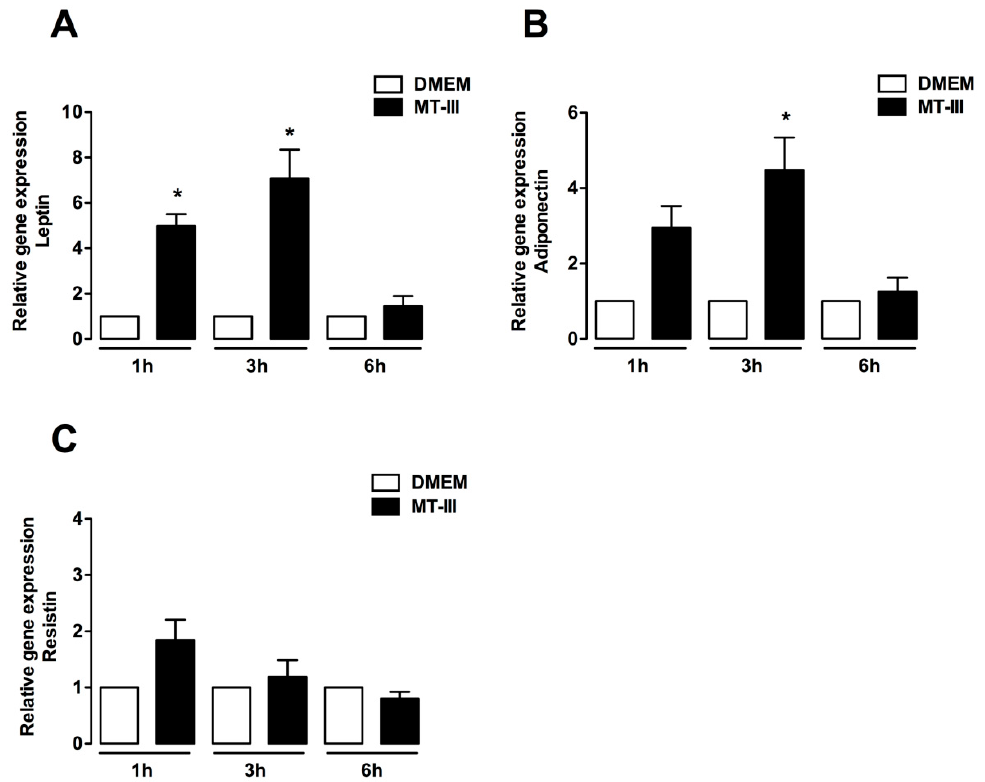
Figure 8. MT-III upregulates gene expression of leptin and adiponectin by 3T3-L1 preadipocytes. Cells were incubated with MT-III (0.4 μ M) or DMEM (control) for 1, 3 or 6 h. Graphs show gene expression of leptin ( A ), adiponectin ( B ) and resistin ( C ) in the presence of MT-III. Concentrations of adipokines were quantified in cell lysates by qPCR. Results are expressed as mean ± SEM from 5 experiments. * p < 0.05 as compared with the control group (two-way ANOVA and Bonferroni posttest).